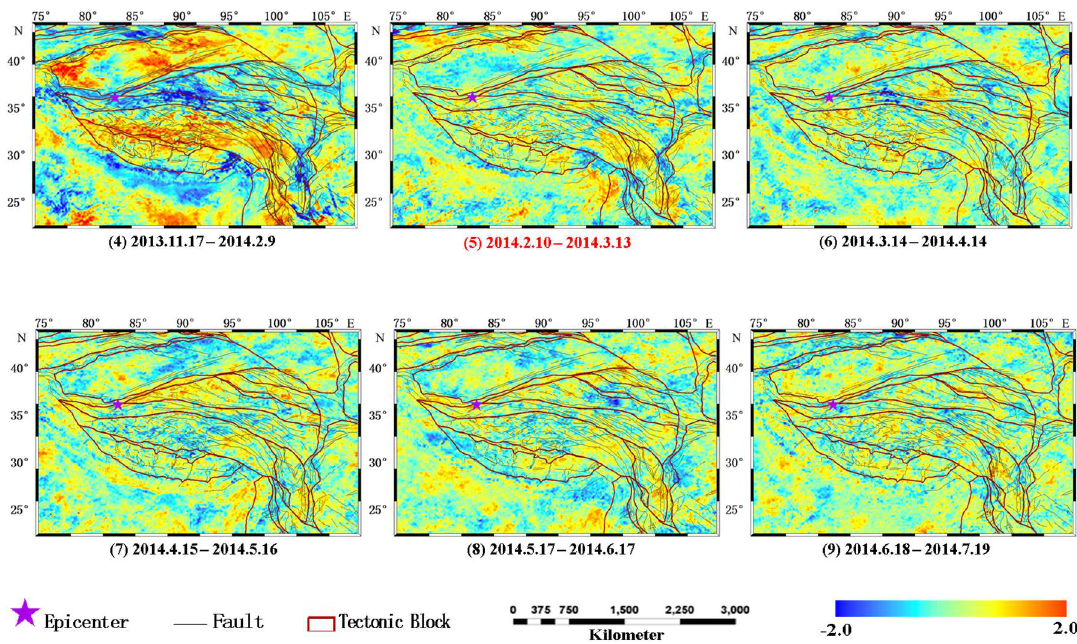
Figure 10. TIR anomalies spatio-temporal presentation of the Ms 7.3 Yutian earthquake based on the proposed TTIA method on the Tibetan Plateau.